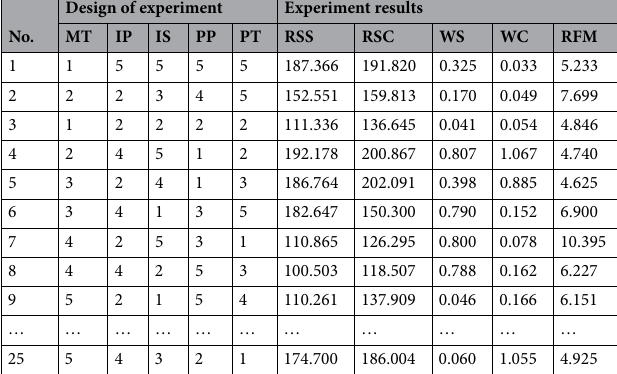
Table 6. The design and results of